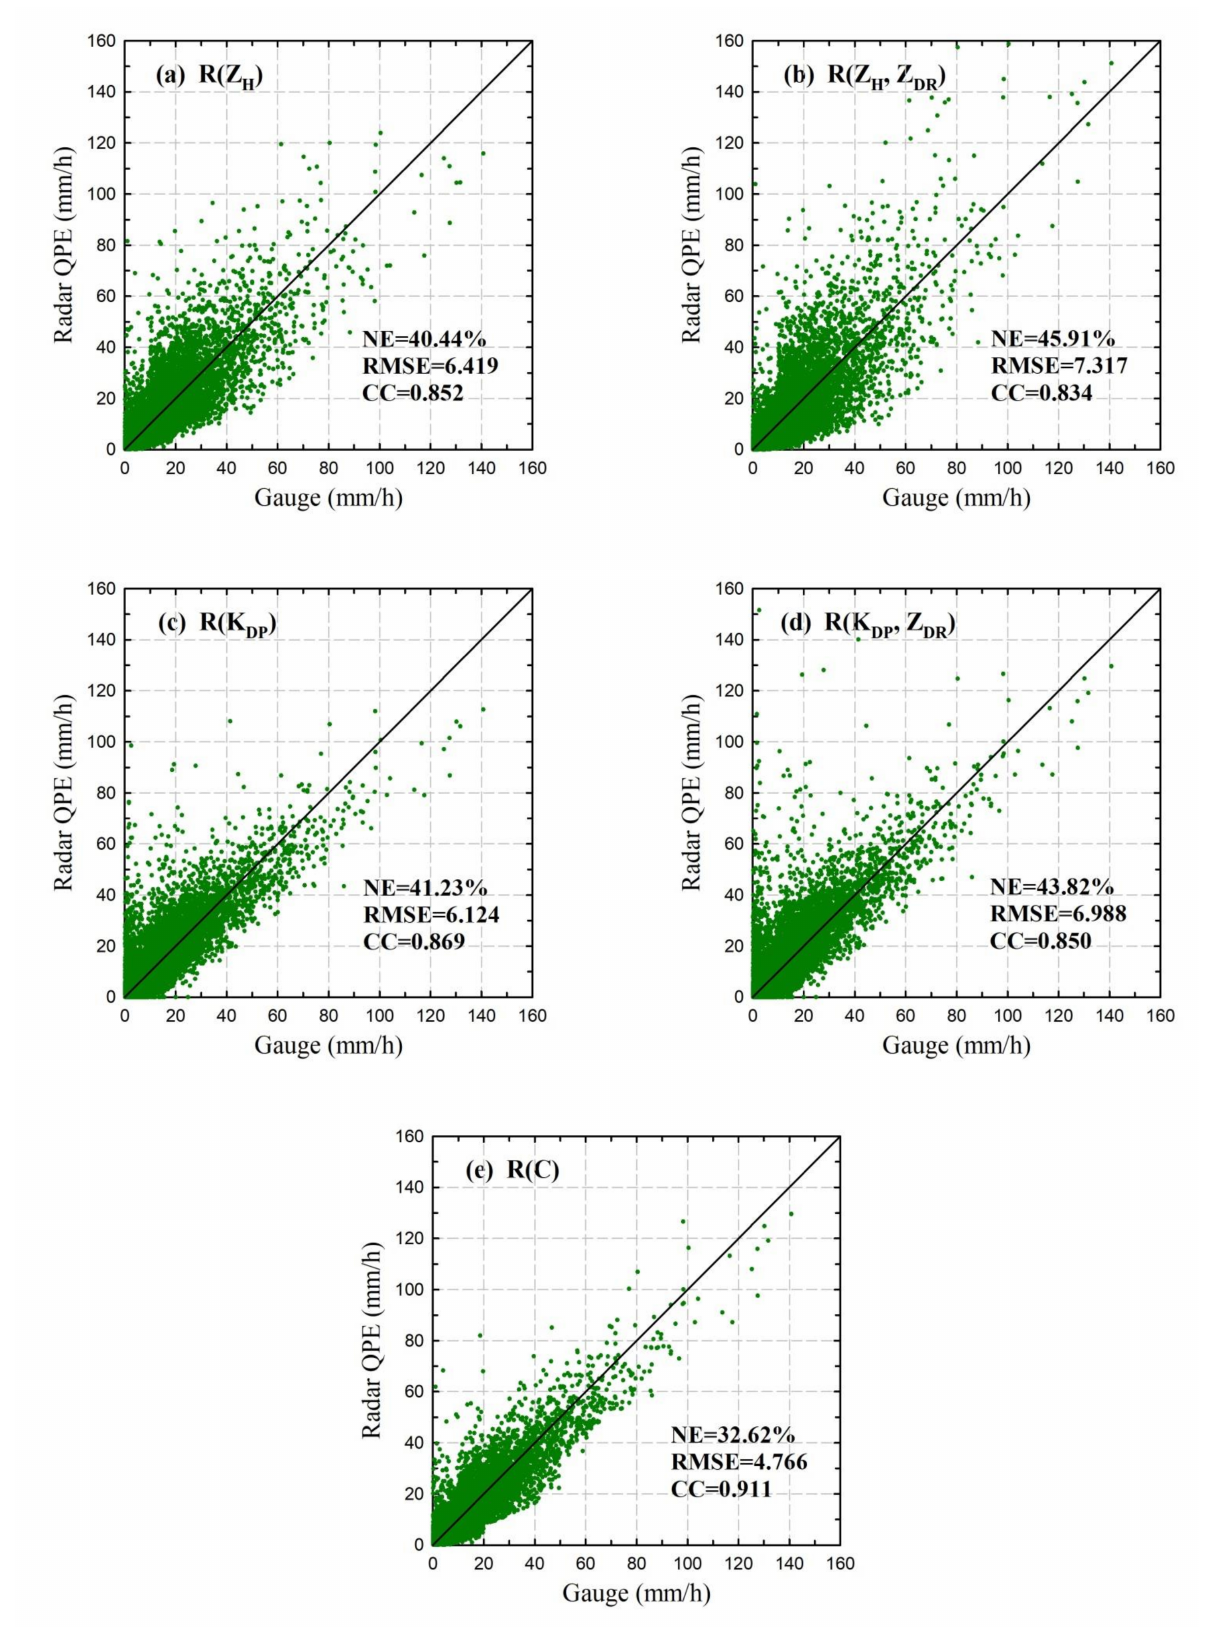
Figure 6. Scatterplots show estimated hourly rainfall from ( a ) R(Z H ), ( b ) R(Z H , Z DR ), ( c ) R(K DP ), ( d ) R(K DP , Z DR ), and ( e ) R(C) compared with rain gauge observations for all eight rainfall